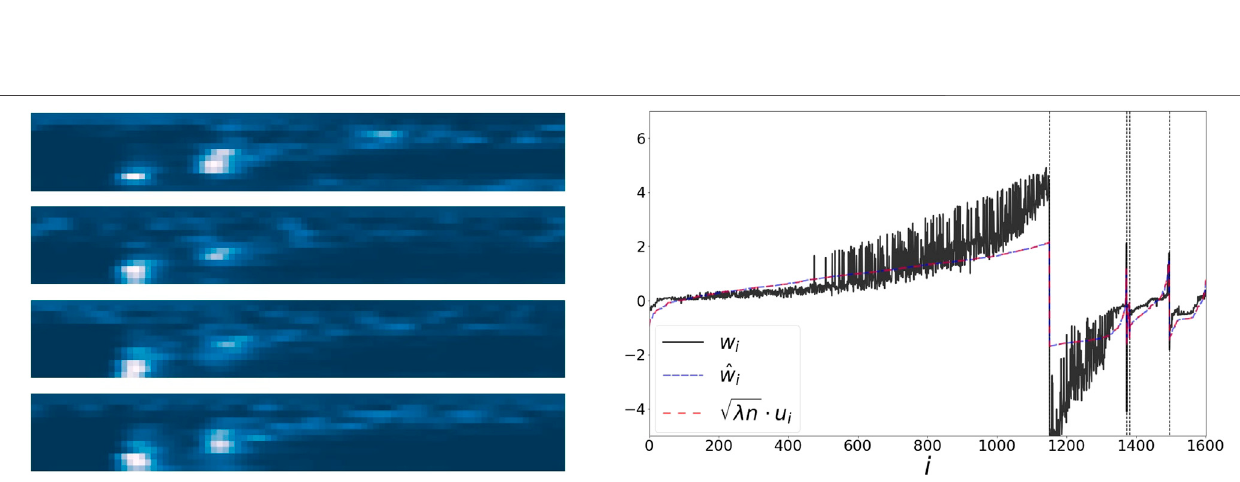
FIGURE 5 | Left: 4 samples from the sonogram dataset, of different event types. Right: The values of the representations w , (cid:13) w and u . Dashed lines annotate the different categories of the events (based on event type and quarry location). Within each category the representations are ordered based on the value of u .